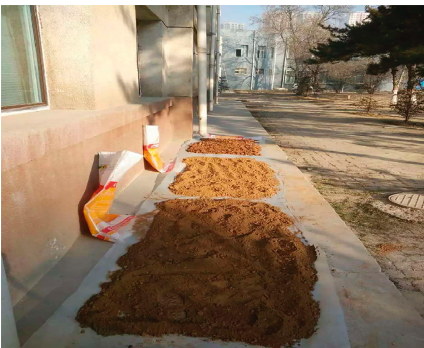
Figure 1: Clay soil used in the test.